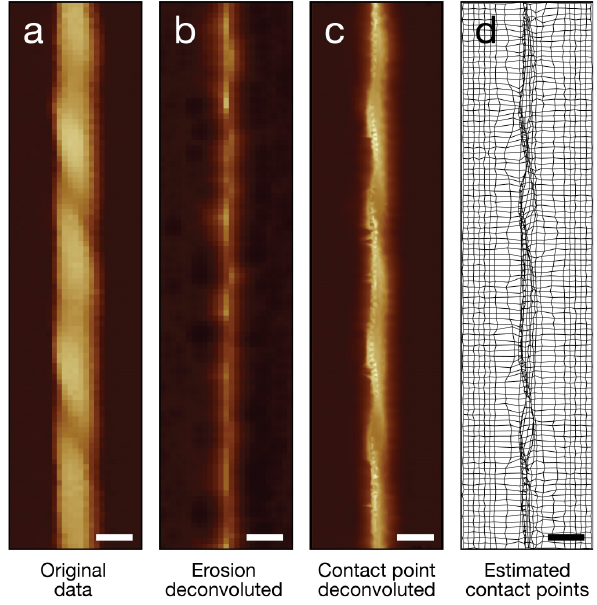
Figure 4: Typical example of contact-point deconvolution of an AFM topograph of a helically twisted amyloid fibril. ( a) Digitally straightened AFM topography image of an amyloid fibril. (b) Image deconvoluted using the erosion algorithm. (c) Contact-point deconvoluted and interpolated image. (d) Corrected lateral (x/y) grid lines after tip-sample contact-point deconvolution. A symmetric conical tip model with a radius of 11.2 nm and side angle of 18° was used. A short section of the total fibril is shown for detail and the corresponding part of the same fibril is shown on each panel. The scale bars represent 20